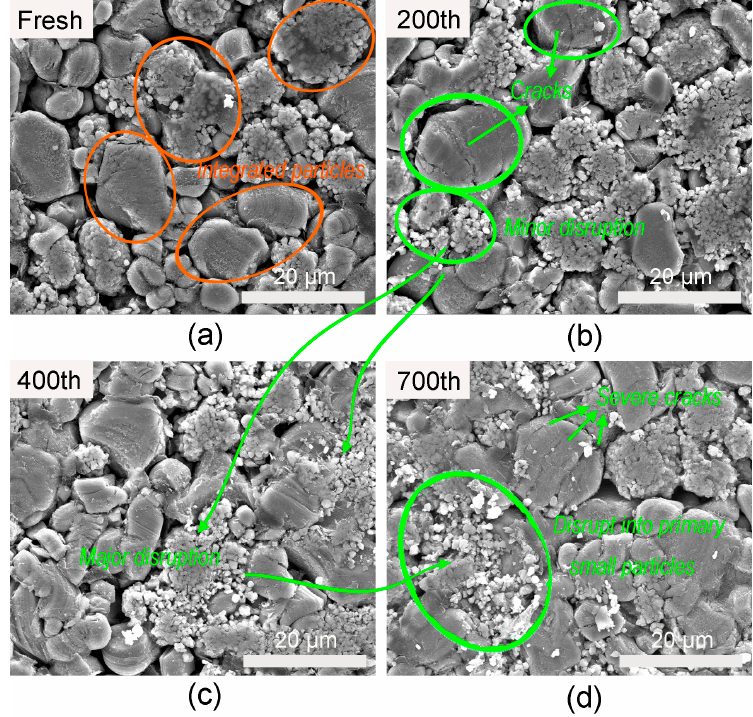
Figure 7. FE SEM images of harvested LCO + NMC532 cathode electrodes experienced various cycles at low magnification: ( a ) fresh; ( b ) 200th; ( c ) 400th; ( d ) 700th.